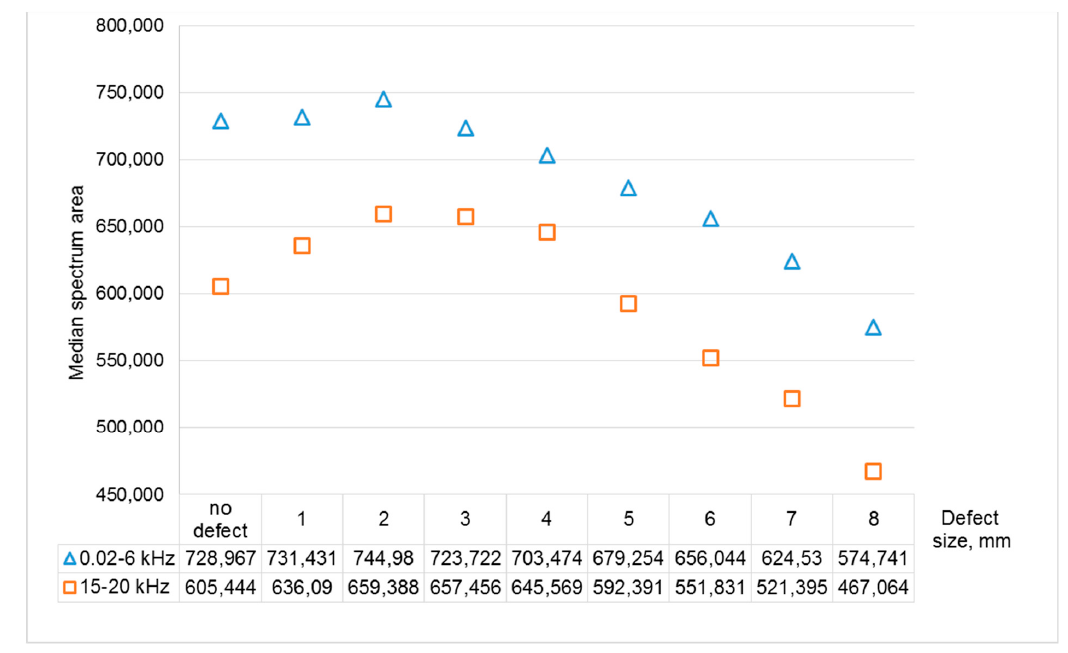
Figure 14. Results of calculations of the area of acoustic spectra.